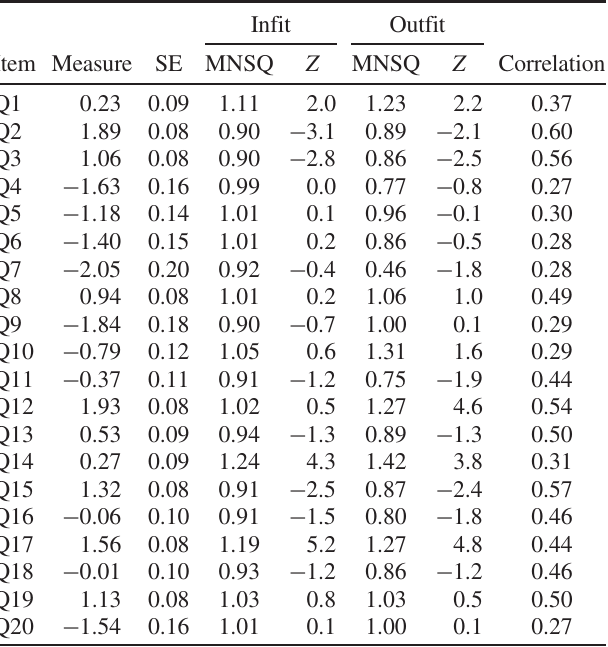
TABLE I. Item difficulty measured in logits, Rasch standard error, infit and outfit MNSQ (mean square residuals) and Z scores, and point-measure correlation for each TUV item. Infit Outfit Item Measure SE MNSQ Z MNSQ Z